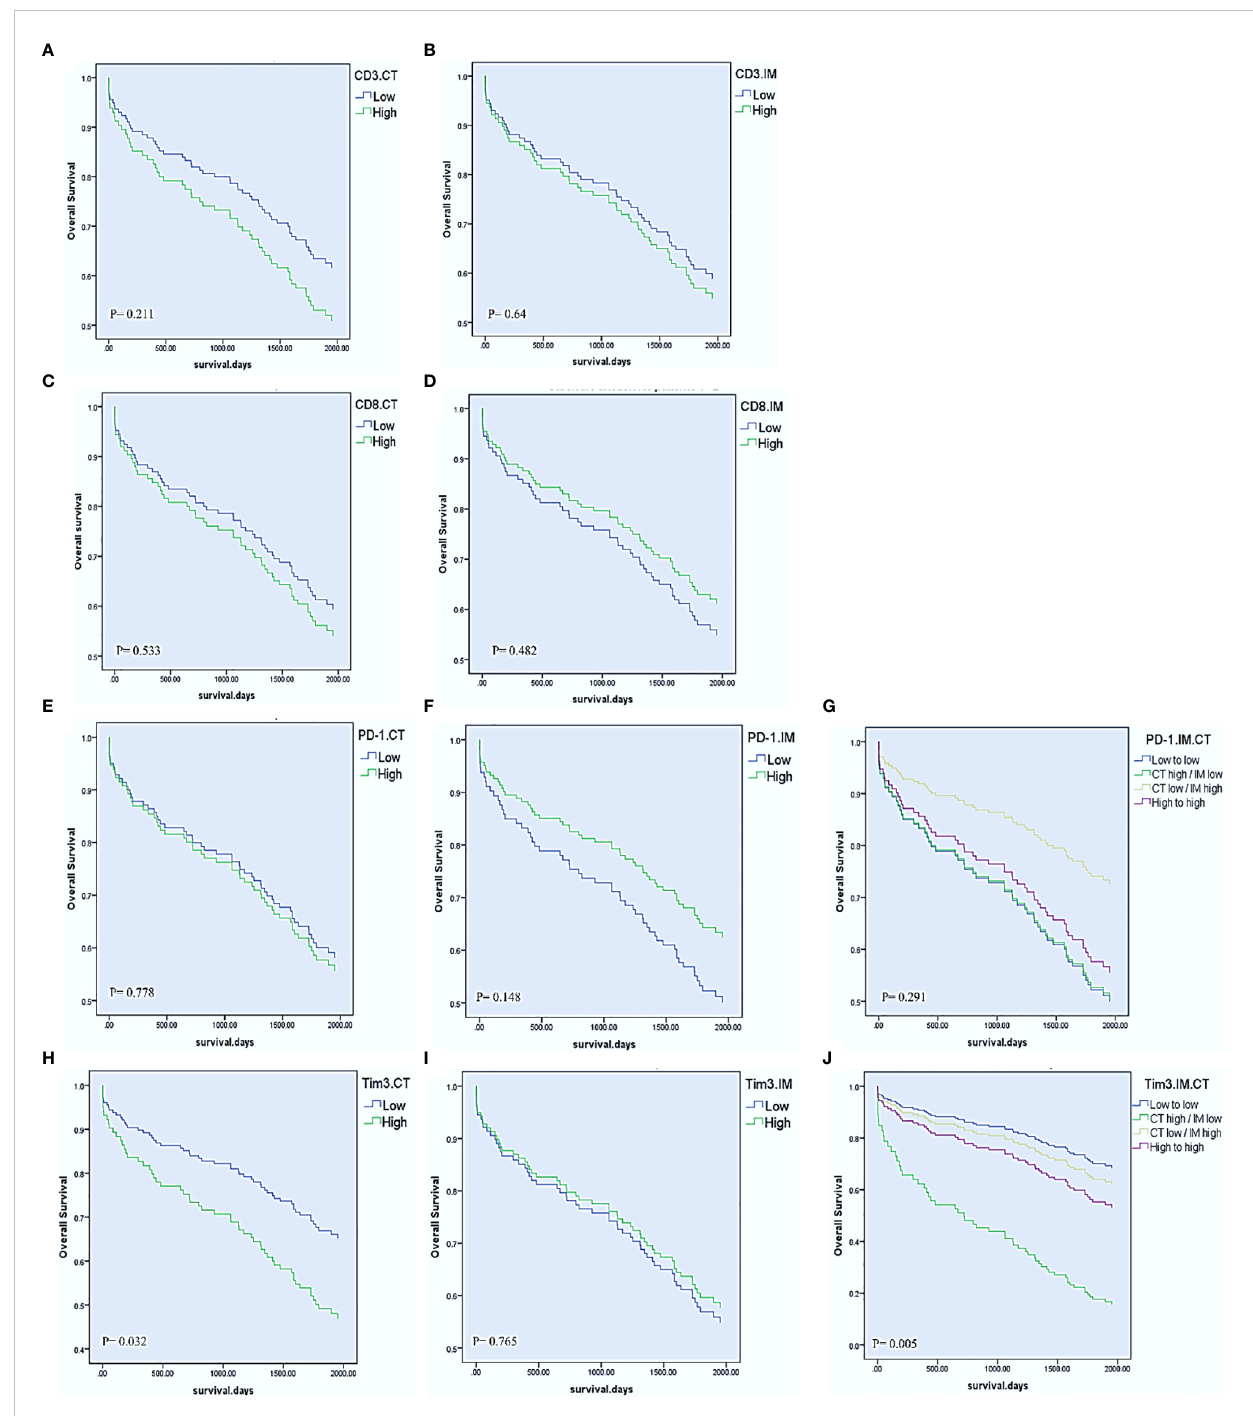
FIGURE 2 Univariable Cox regression estimates of overall survival according to CD8, CD3, PD-1, and Tim3 high vs low expression in the center of the tumor (CT) and invasive margin (IM). CD3 and CD8 in the CT and IM (A – D) . PD-1 expression in the CT, IM, and combination of IM with CT (E – G) . Tim3 expression in the CT, IM, and combination of IM with CT (H – J)